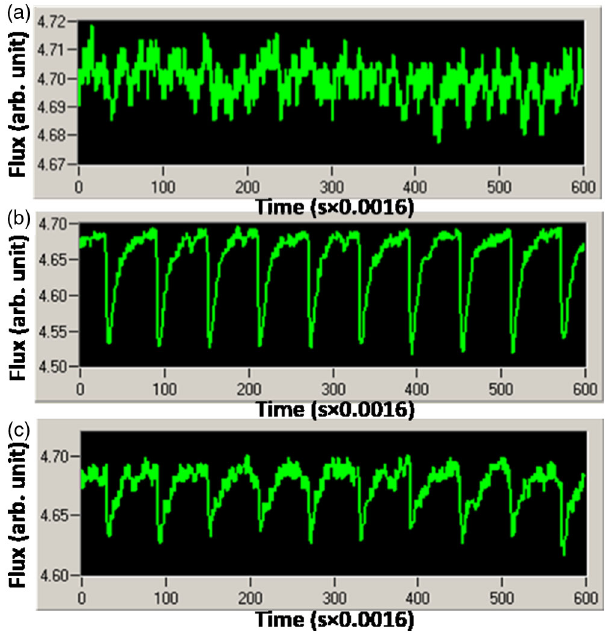
9. Measured mesh current at the beam line. Mesh current is acquired at 600 Hz. (a) No injection. (b) Main injection system on. (c) Main injection system and fast counterkicker